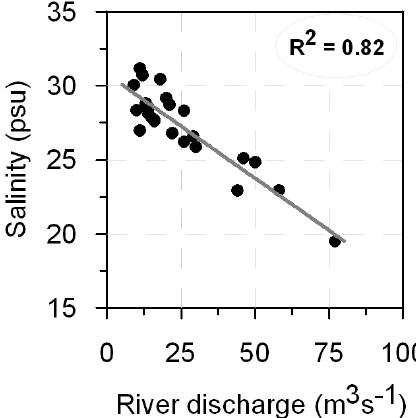
Fig. 2. Salinities observed at 8km far from the mouth of the Sumjin River Estuary as a function of river